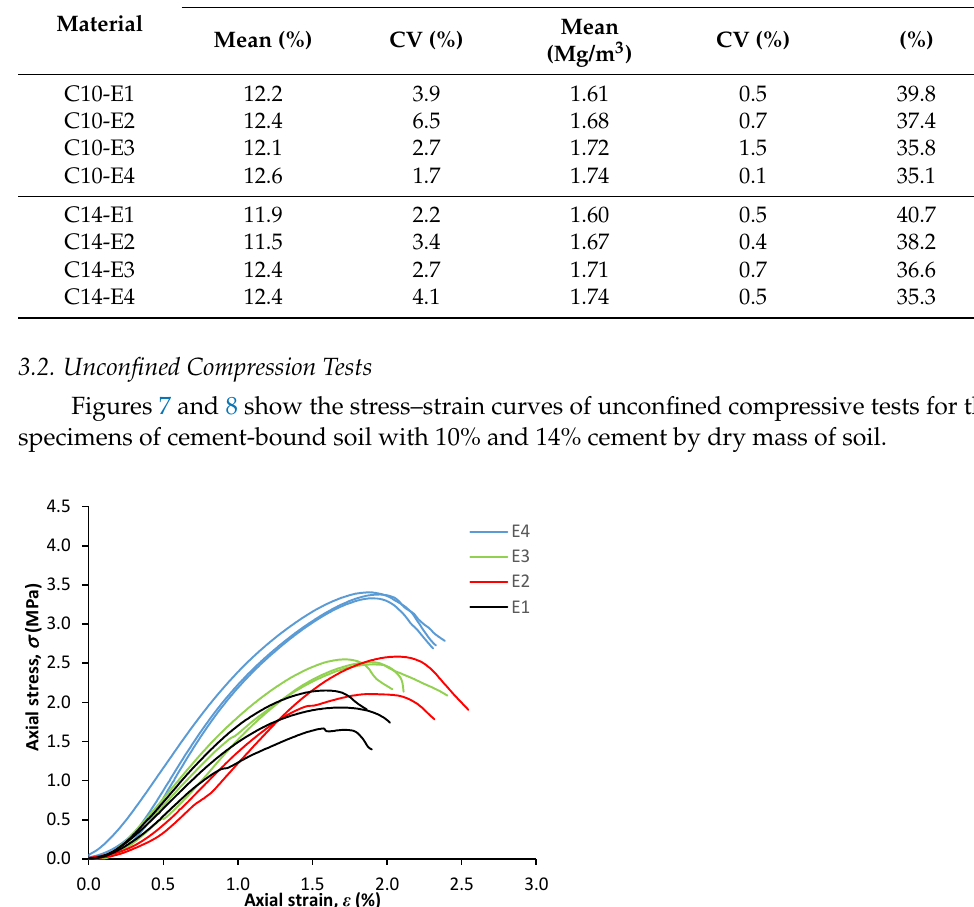
Table 4. Properties of specimens.